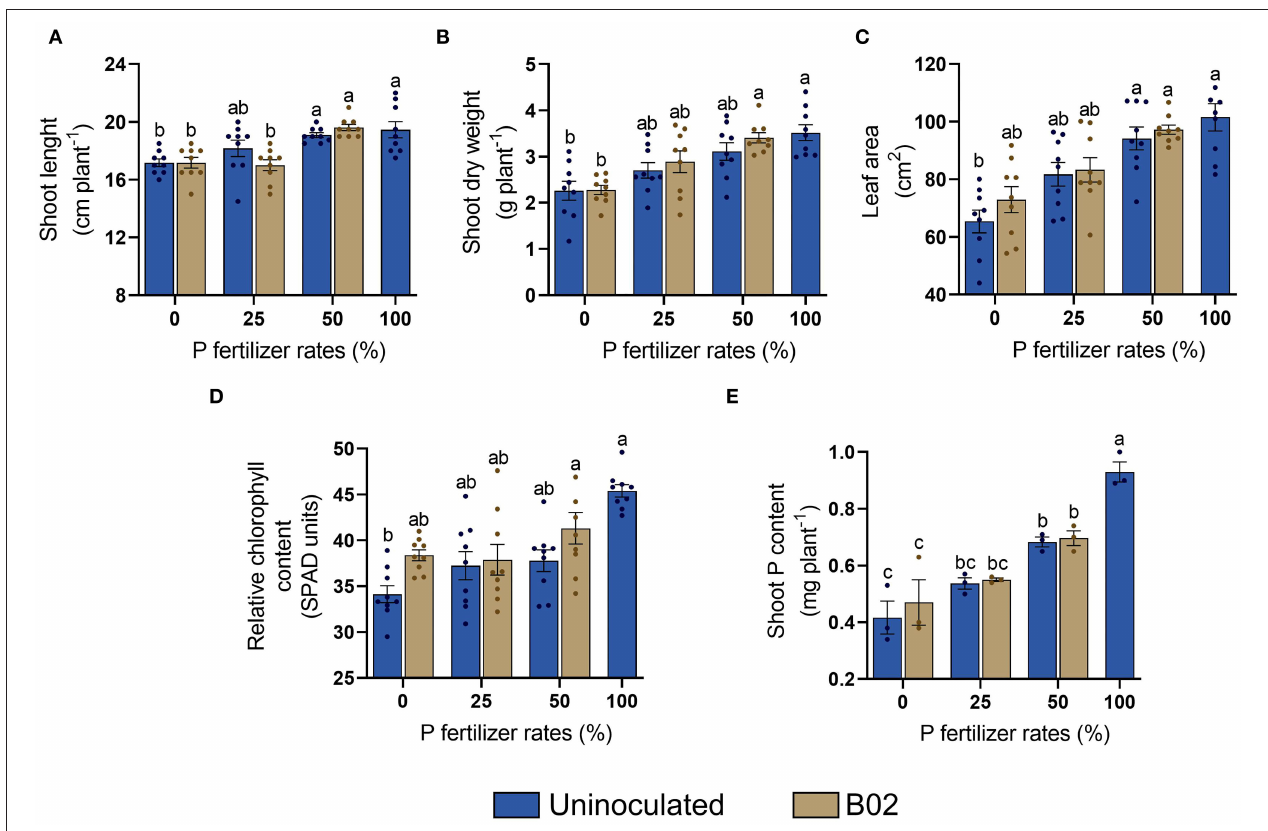
FIGURE 1 | Influence of inoculation with Rhizobium sp. B02 on shoot length (A) , shoot dry weight (B) , leaf area (C) , relative chlorophyll content (D) , and shoot P content (E) of the white endosperm genotype of maize at the vegetative stage of tillering (V5). Except for shoot P content (three measurements), the means and standard errors resulted from three replicates and three independent repetitions (nine measurements). Different letters indicate significant differences according to Tukey’s test ( p < 0.05).